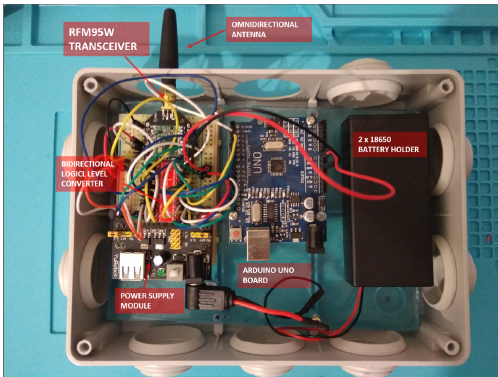
Figure 5. Detail of the system assembly. Principal subnode.